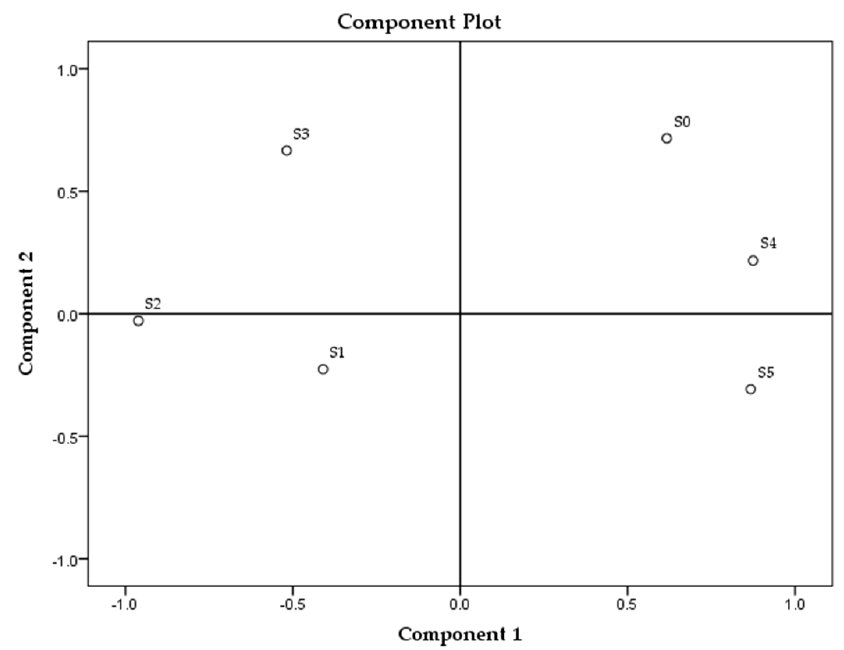
Figure 3. Principal component analysis of soap samples made of sunflower oil. * Samples’ description is given in Table 1.